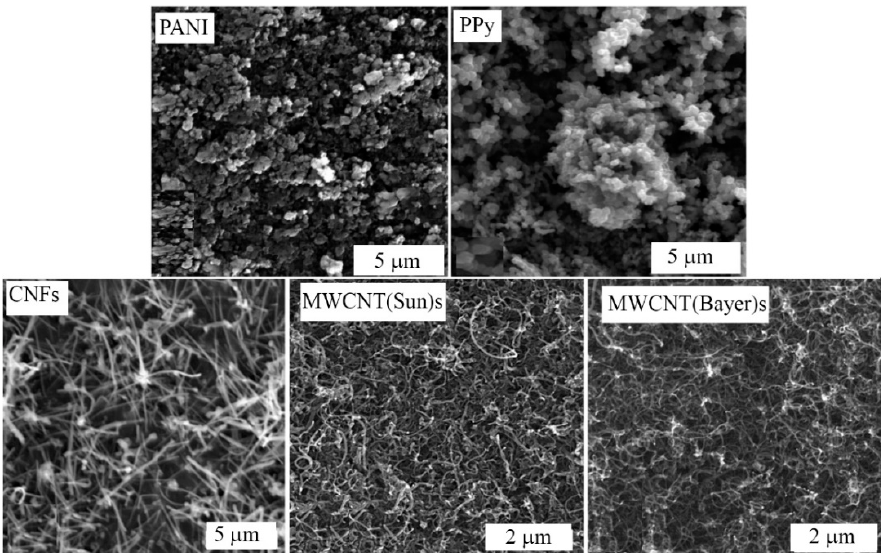
Figure 3. SEM micrographs of a surface of layers made of organic and inorganic fillers. The respective fillers are denoted in the images.